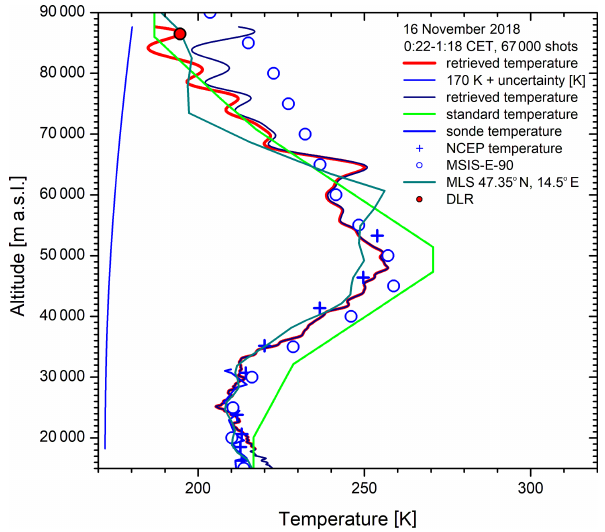
Figure 18. Temperature profile from the measurement in Fig. 21, in comparison with data from the Munich 01:00CET radiosonde, NCEP (13:00CET), the MSIS model and MLS; the temperatures were retrieved from the lidar signal by initializing the temperature at about 87km using both the U.S. Standard and the MSIS values. Both retrievals converge to the same curve within 15–20km from the top. The red dot shows the temperature from OH airglow mea- surements at UFS by